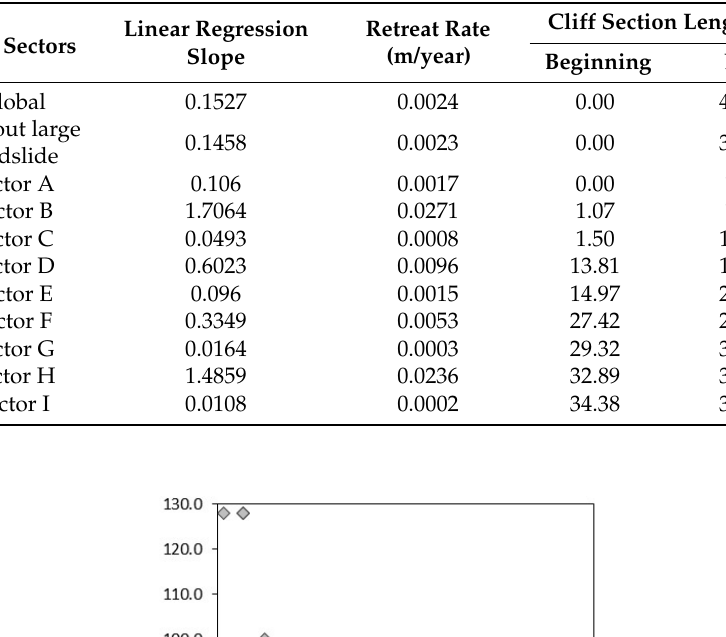
Table 1. Mean annual cliff retreat rates computed from linear regression of the space distribution of planimetric area lost at the cliffs top. Sector extension in Figures 1 and 2b, and lithology in Figure 2b.